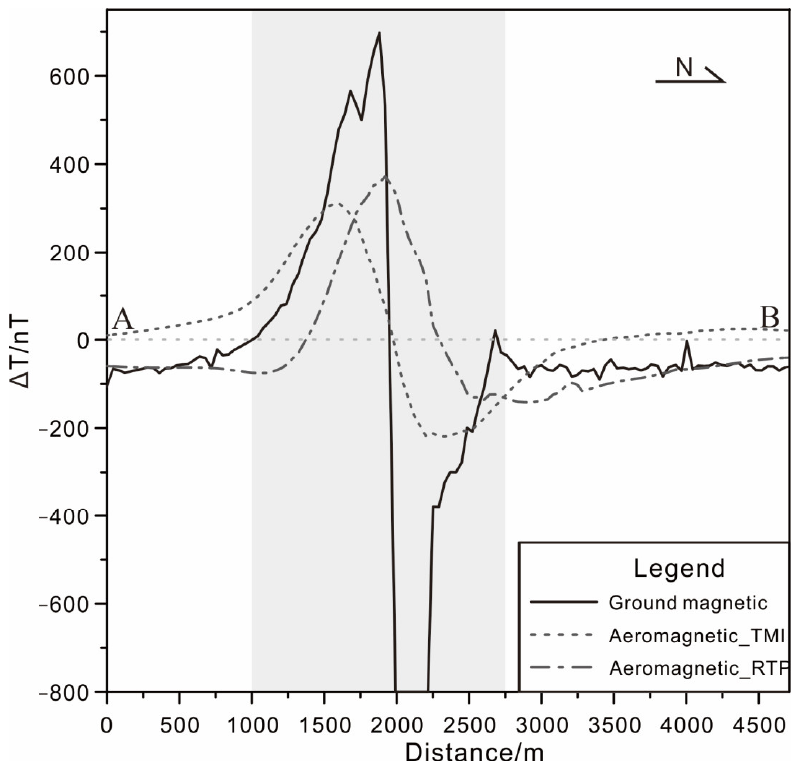
Figure 5. Aeromagnetic and ground magnetic anomaly curves of the section along Line AB. Aero- magnetic_TMI and Aeromagnetic_RTP anomaly curves were sampled from Figure 3b,c.